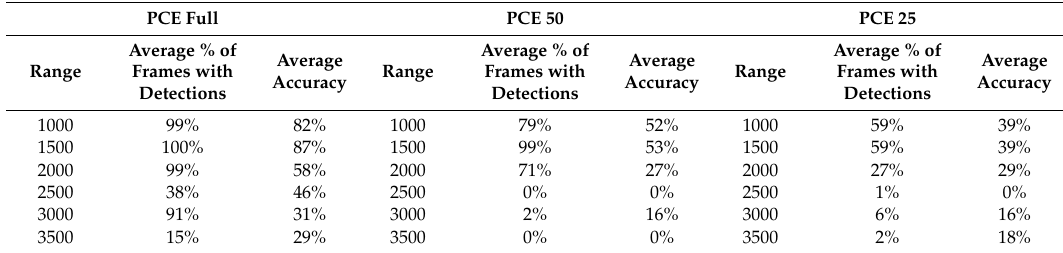
Table 4. Averaged tracking and classification performances for the various optical video cases. 1500 m and 3000 m videos were used for